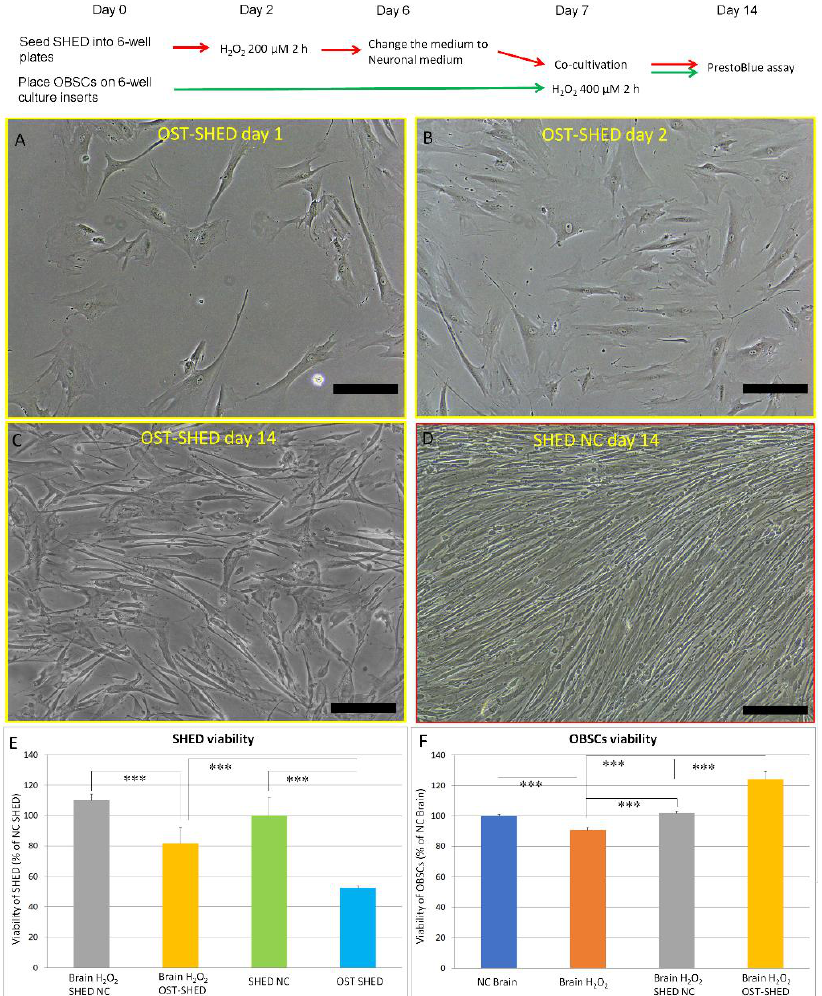
Figure 2. Cell viability of OBSCs and SHED at the end of cultivation. ( A – C ), Morphology of OST-SHED. ( A ), One day after H 2 O 2 treatment; ( B ), Two days after H 2 O 2 treatment; ( C ), Two weeks after H 2 O 2 treatment. ( D ), Morphology of normal SHED (negative control, SHED NC), cells were cultivated under the same conditions without H 2 O 2 treatment. Scale bar = 50 μm. ( E , F ), At the end of cultivation, the culture inserts (which containing OBSCs) were transferred into new 6-well plates and followed by presto blue assay. Co-cultivated SHED and solo-cultivated SHED were also followed by presto blue assay. Data are presented as mean ± SD. *** p < 0.001. SHED NC (normal SHED), SHED without H 2 O 2 treatment, OST-SHED, SHED with H 2 O 2 treatment, NC Brain, OBSCs solo-cultivated without H 2 O 2 treatment, Brain H 2 O 2 , OBSCs solo-cultivated with H 2 O 2 treatment, Brain H 2 O 2 SHED NC, OBSCs treated with H 2 O 2 and co-cultivated with normal SHED, Brain H 2 O 2 OST-SHED, OBSCs treated with H 2 O 2 and co-cultivated with OST-SHED, (The abbreviations are also applied in the rests).